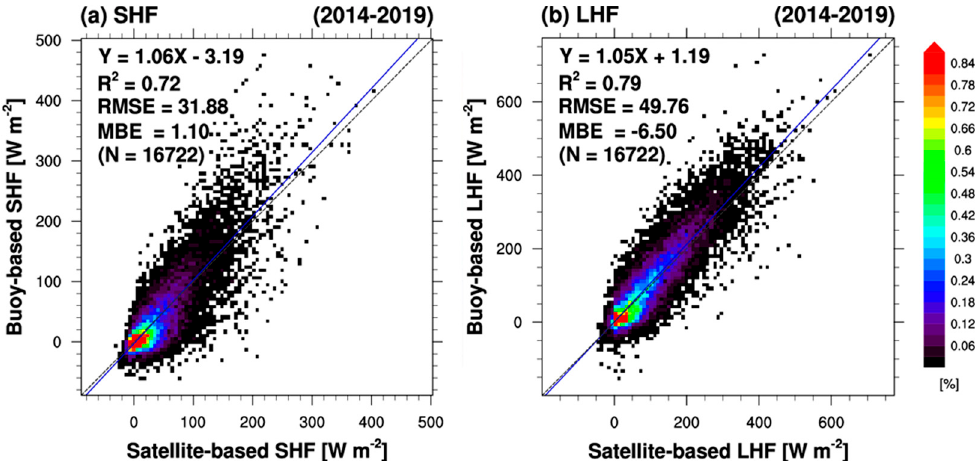
Figure 4. Comparison between satellite-derived and buoy-based ( a ) sensible heat flux (SHF) and ( b ) latent heat flux (LHF) at all buoy sites during the period 2014–2019. Dashed and blue lines indicate the 1:1 line and regression line, respectively. The color scale represents the density (%) of the data points.